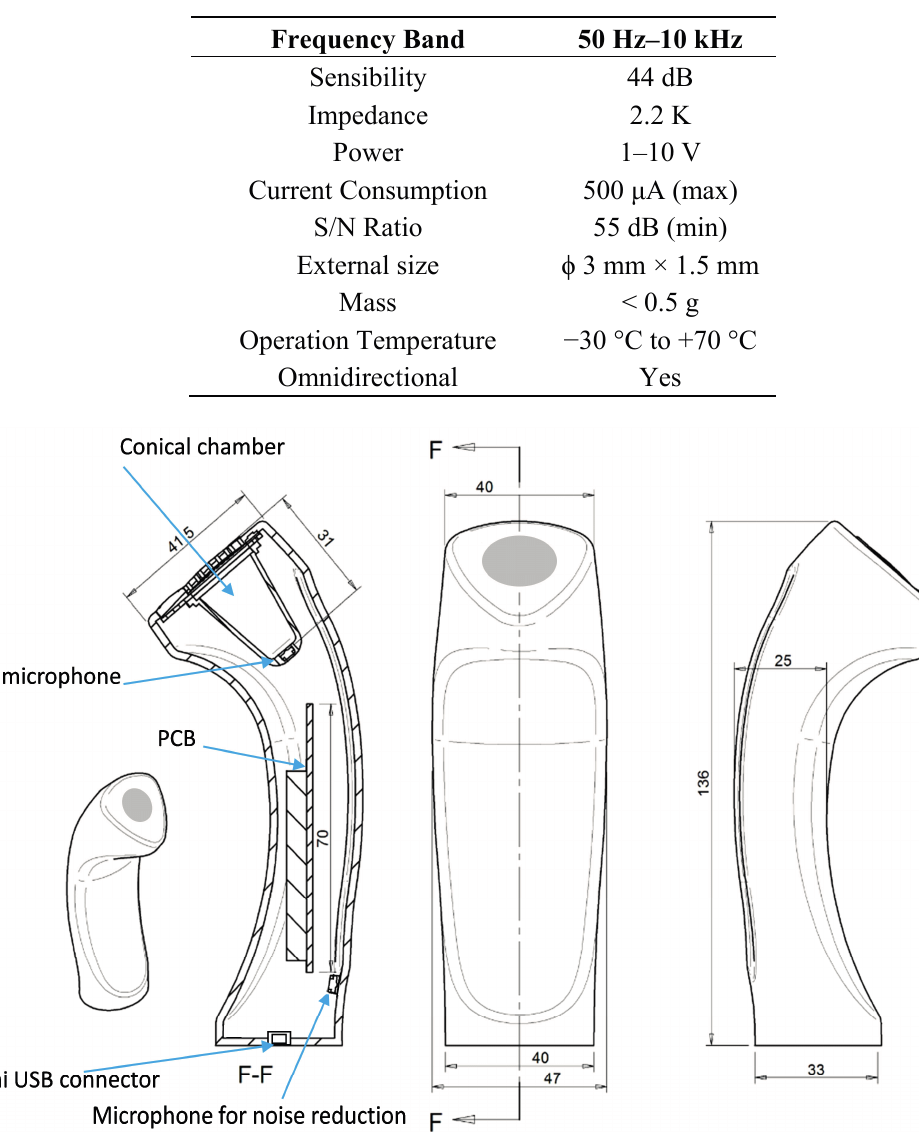
Table 1. Technical specifications of the selected microphone.